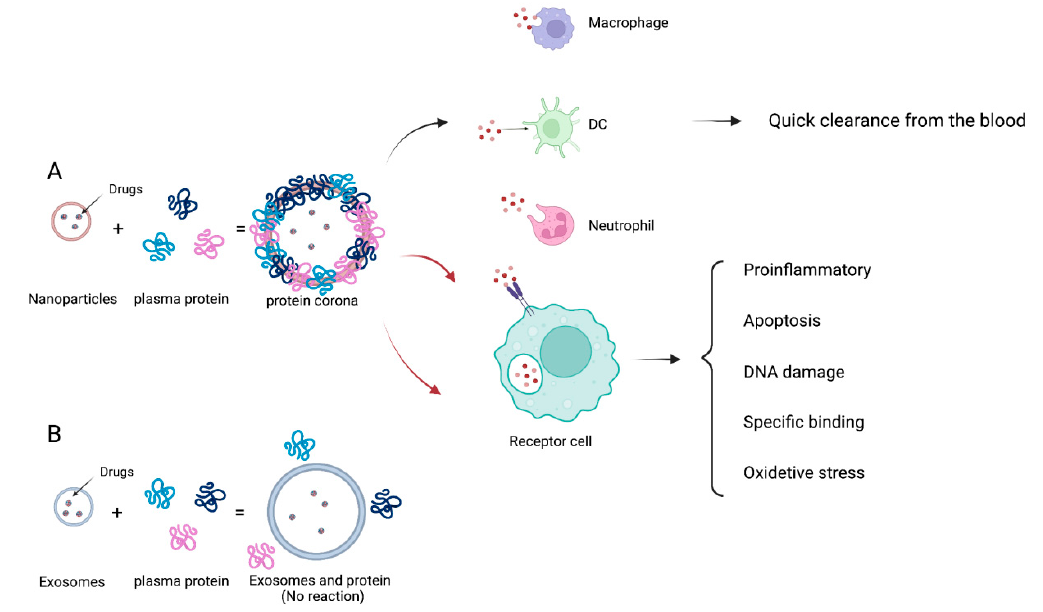
Figure 2. The schematic representation of the biological reaction of the protein crown in blood circulation. ( A ) Various plasma proteins adsorb onto NPs immediately after the synthetic NPs enter the blood, resulting in rapid clearance and cytotoxicity; ( B ) exosomes weakly bind with the serum proteins, thereby enhancing the circulation time and decreasing the cytotoxicity.